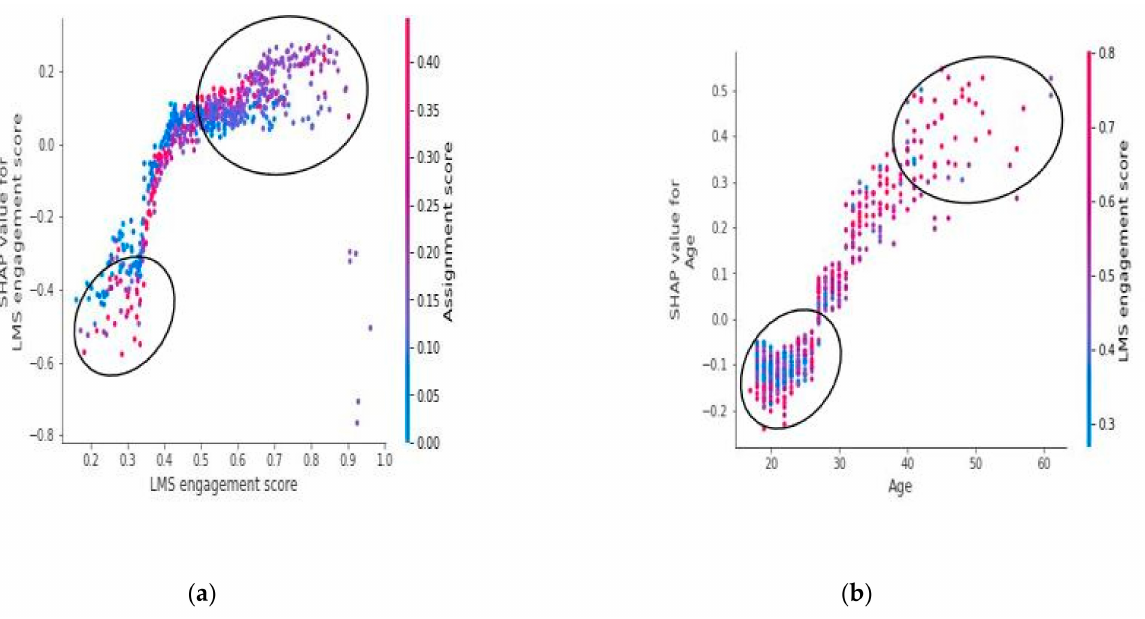
Figure 4. Two SHAP scatter dependence plots. ( a ) interaction between LMS engagement score and assignment score. ( b ) interaction between age and LMS engagement